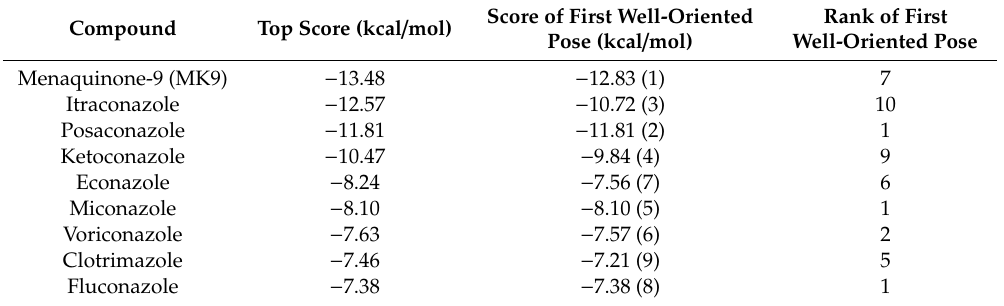
Table 3. Final results obtained after re-docking MK9 and azole drugs on equilibrated CYP128A1 models. The compounds are ranked according to their top docking score, from highest to lowest a ffi nity (column 2). Column 3 shows the score of the first well-orientated pose with respect to the catalytic site. In the case of MK9, proper orientation means that the hydrophobic tail of MK9 is facing the ferric ion of heme, which is consistent with omega hydroxylation of the molecule reported elsewhere [13,16]. For azole drugs, the imidazole ring is facing Fe of heme and the tail should be out of the cavity. In column 3, numbers in parenthesis refer to the rank of the compound based on that score (over all compounds). In column 4, we reported the rank of the first well-oriented pose among all the poses generated for each